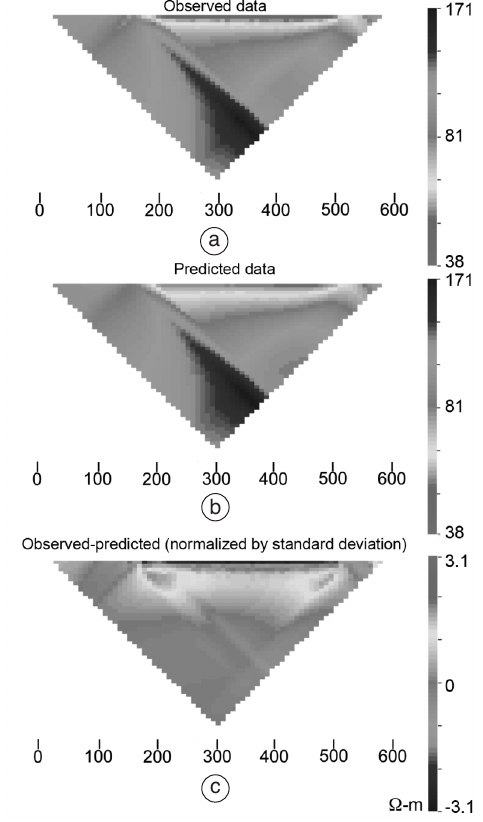
Fig. 12a-c. Result of geophysical inversion, pdL con- figuration, Model 2, Scenario 1, at 700 days: a) ob- served data, b) predicted data, c) difference between observed and predicted